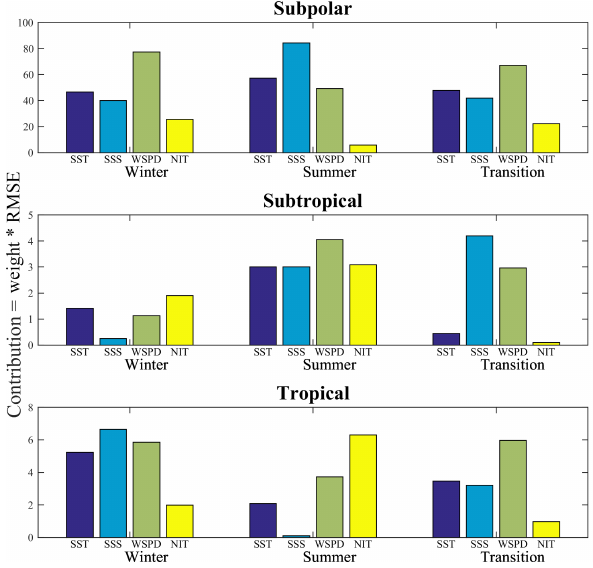
Figure 9. Contributions of each of the variables p CO 2 , SST, SSS, and WSPD to the overall air–sea flux (cid:49)F bias. The contributions are computed as the products of the weights and the RMSEs of each variable q as described in Eq. (5). See the text for a detailed expla- nation.